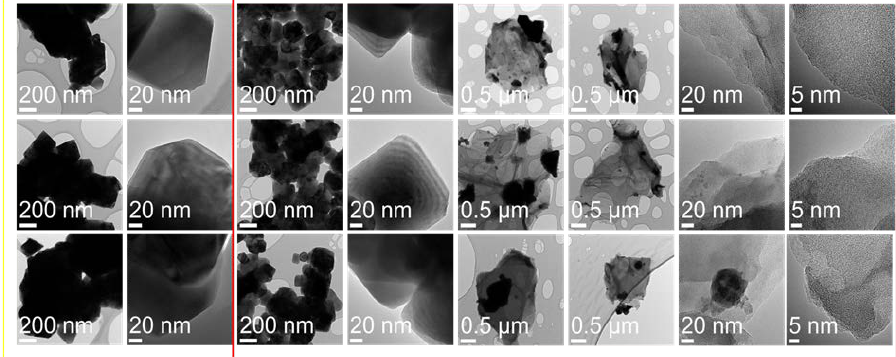
Figure 4. TEM images of LMO (yellow) and LMO with 5% wt. GO (red). The EDS analysis for manganese (Mn), oxygen (O), and carbon (C) elements was performed for sample LMO with 5% wt. GO to confirm the presence of a carbon structure on LMO surface grains. The results are depicted in Figure 5. It may be that graphene oxide flakes are covering the LMO grains.